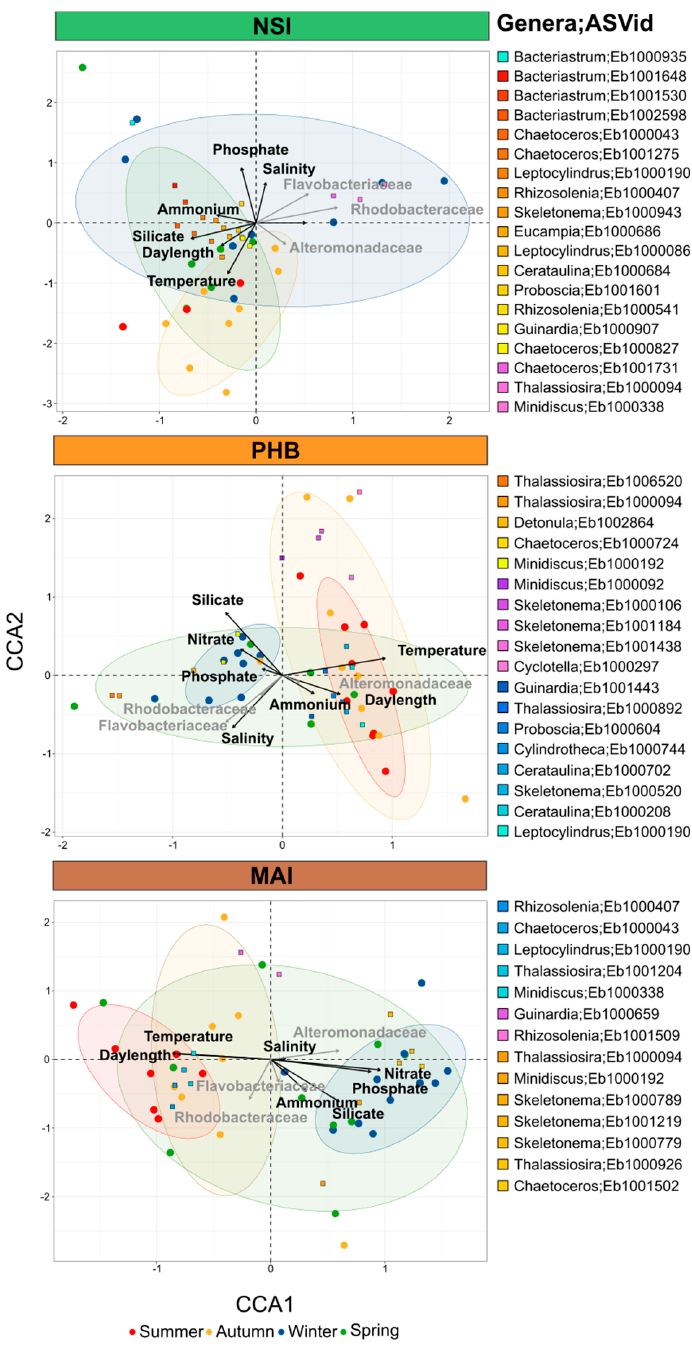
Figure 6. Seasonality of Diatom Communities at North Stradbroke Island, Port Hacking and Maria Island. Diatom communities over 5 years displayed using Canonical Correspondence Analysis (CCA) of rarefied diatom ASVs, highlighting the environmental and biological drivers of seasonality. Black arrows represent the influence of each environmental variables (temperature, salinity, silicate, phosphate, ammonium and nitrate) and grey arrows correspond to the influence of three bacteria families most commonly found in association with phytoplankton (Rhodobacteraceae, Flavobacteriaceae, Alteromonadaceae). Ellipses correspond to the confidence level (80%) at which to draw the ellipse for each season (Summer = red, Autumn = yellow, Winter = blue, Spring = green).